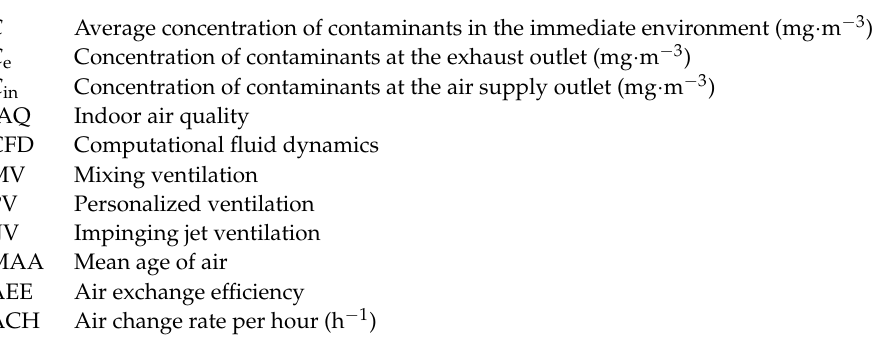
point; Figure S2. SF6 concentration at different locations; Figure S3. Grid condition of CFD model; Figure S4. The concentration of pollutants and velocity for different grids; Figure S5. Monitoring surface position; Figure S6. The normalized concentration of ammonia at Z = 0.9 m section; Figure S7. The normalized concentration of hydrogen sulfide at Z =0.9 m